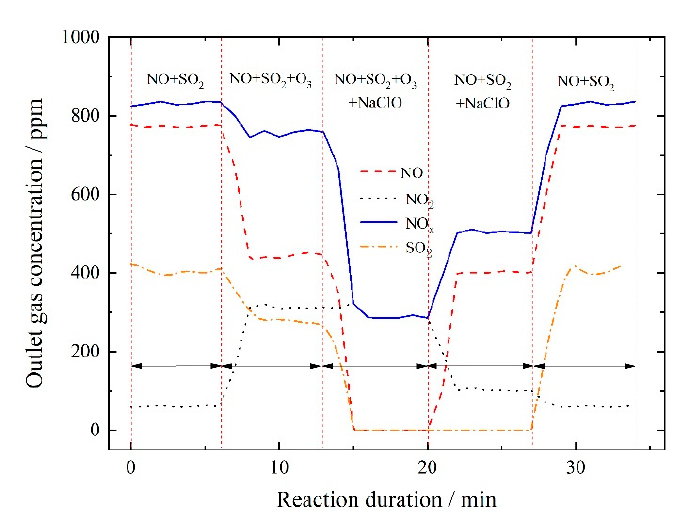
Figure 10. The changes of outlet gas concentrations with the reaction duration in the test of in-situ combination of 400 ppm ozone injection and wet scrubbing 0.04 mol·L − 1 NaClO solution.